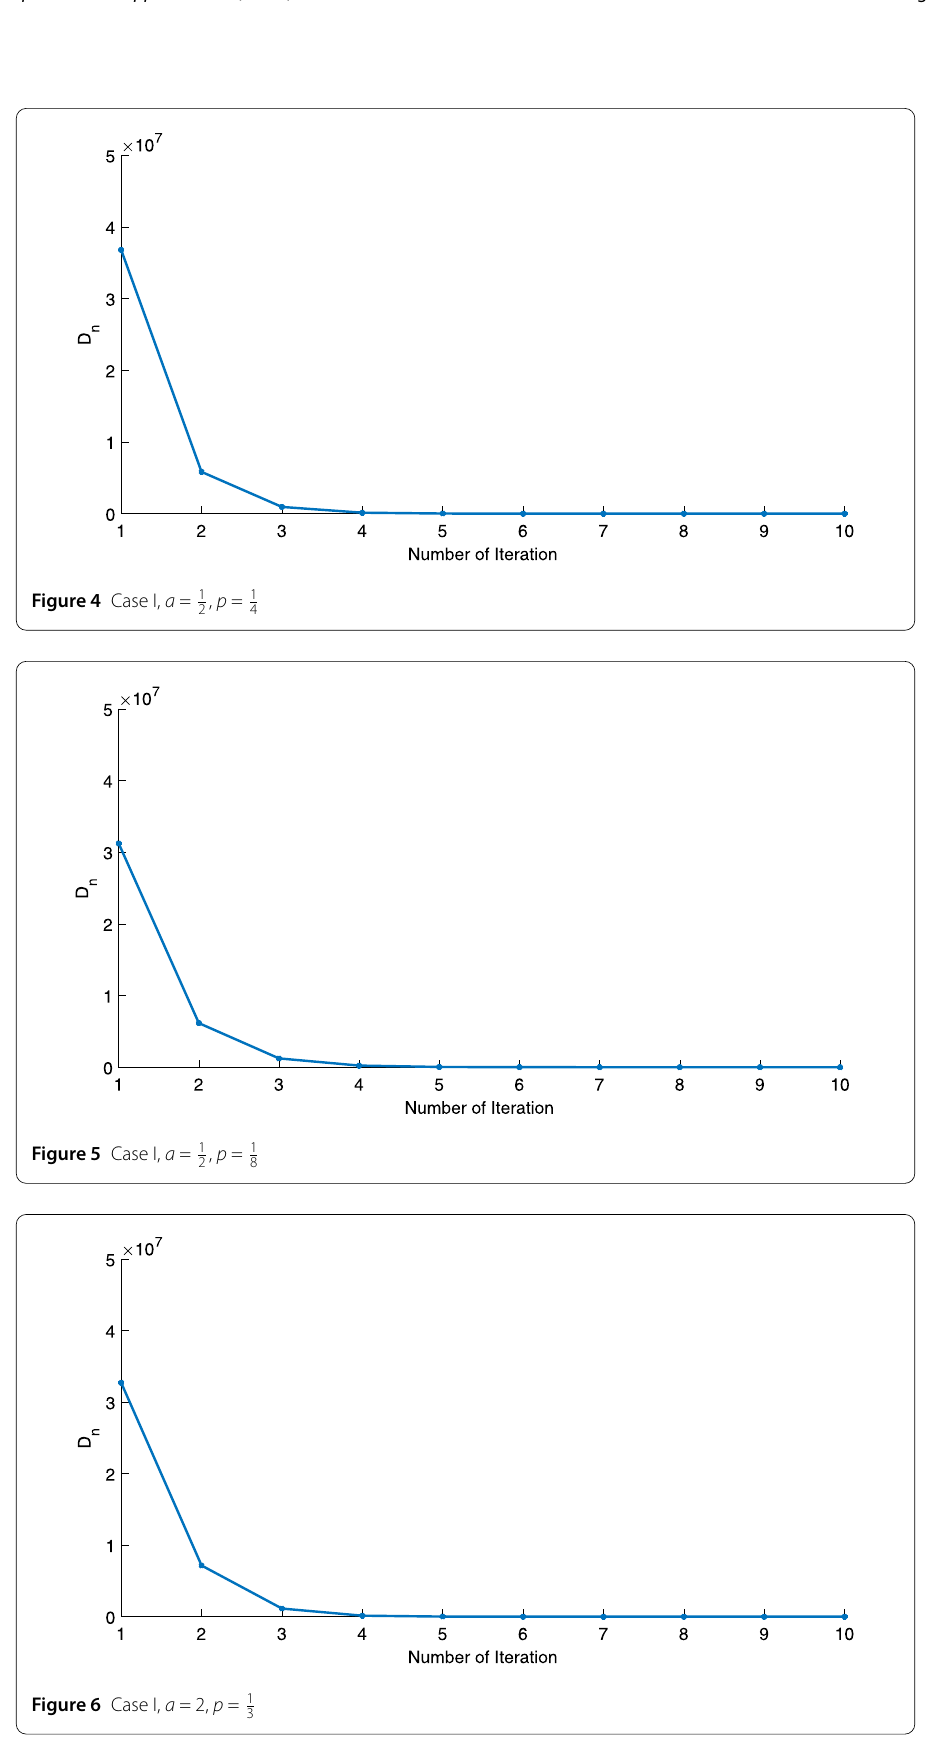
Figure 6 Case I, a = 2, p = 1